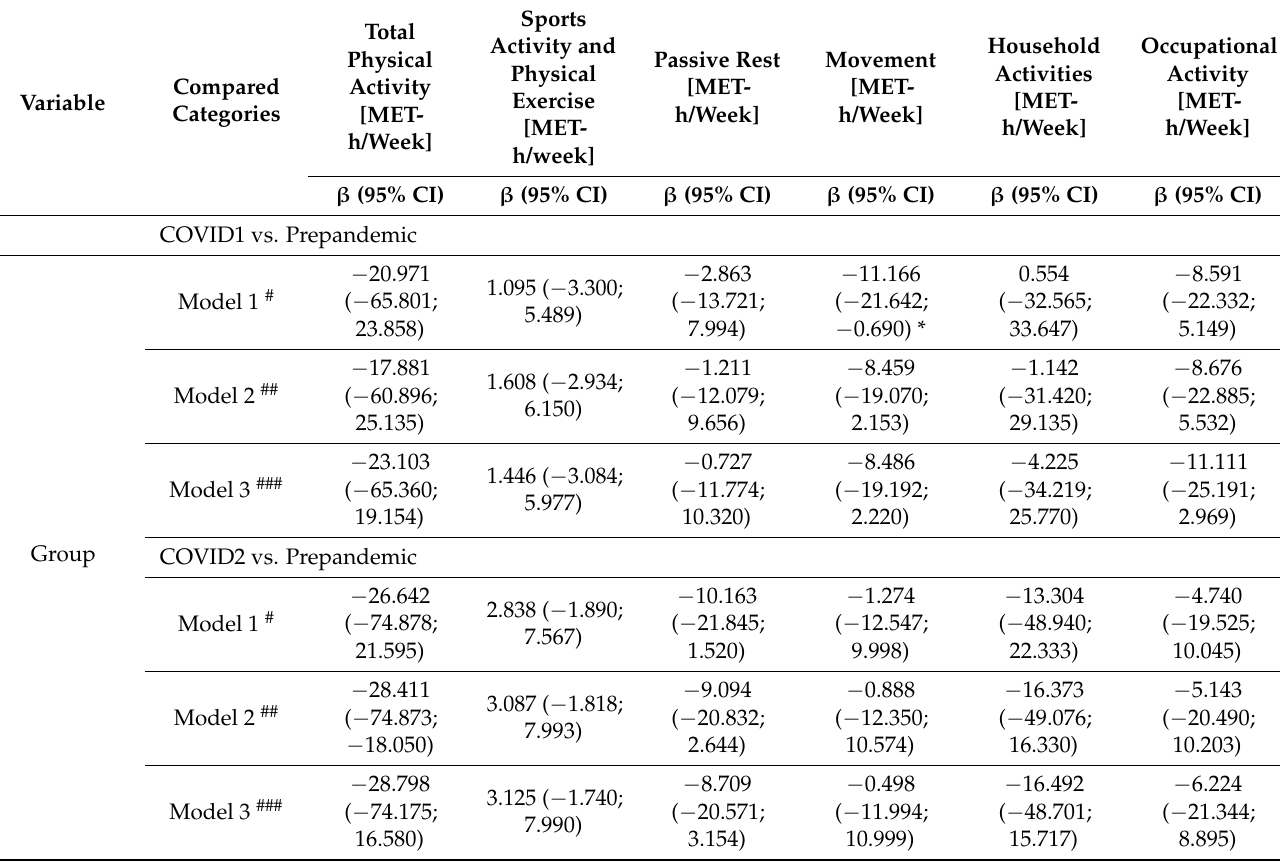
Table 5. Regression analysis—type of physical activity—women at risk of